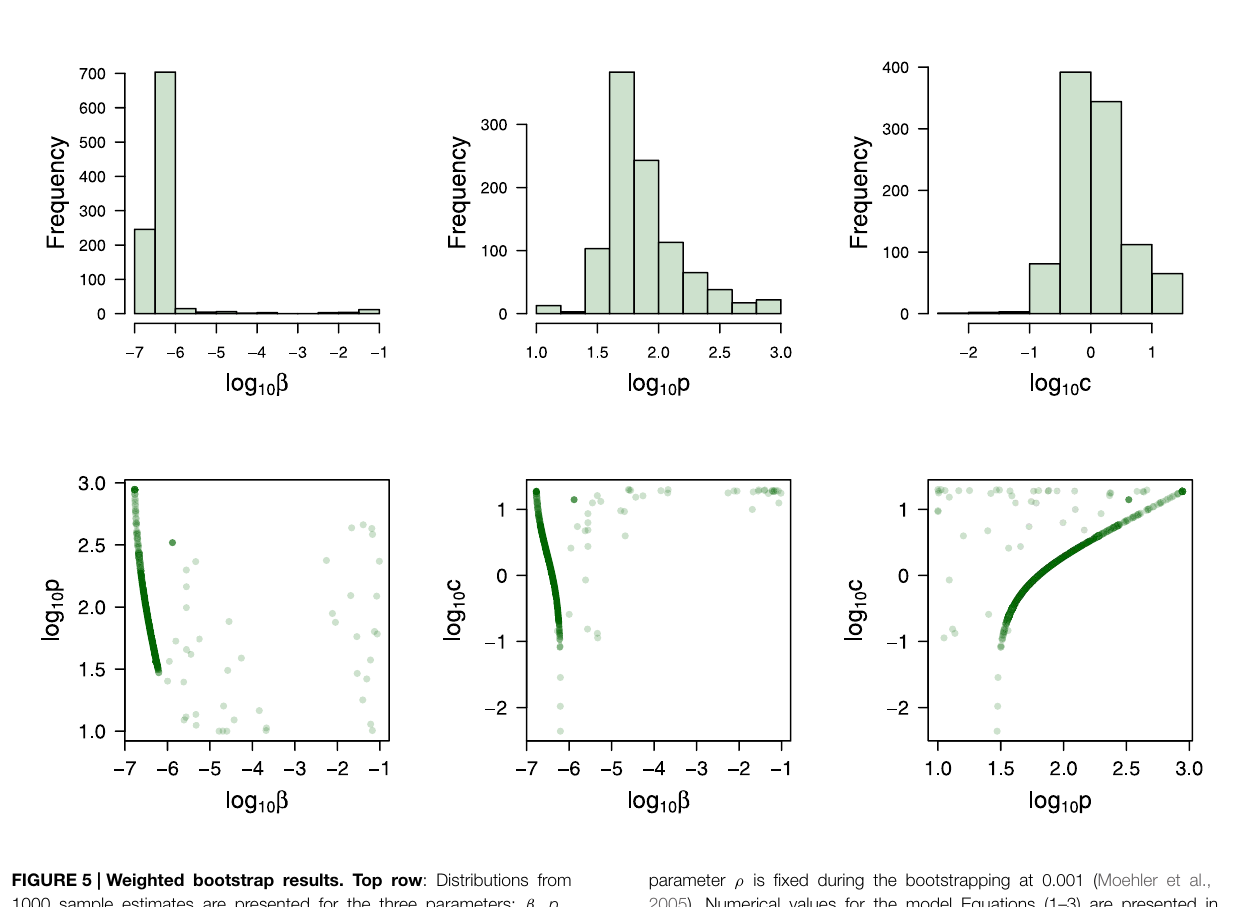
FIGURE 5 | Weighted bootstrap results. Top row : Distributions from 1000 sample estimates are presented for the three parameters: β , p and c . Bottom row : Scatter plot between bootstrap parameters. The